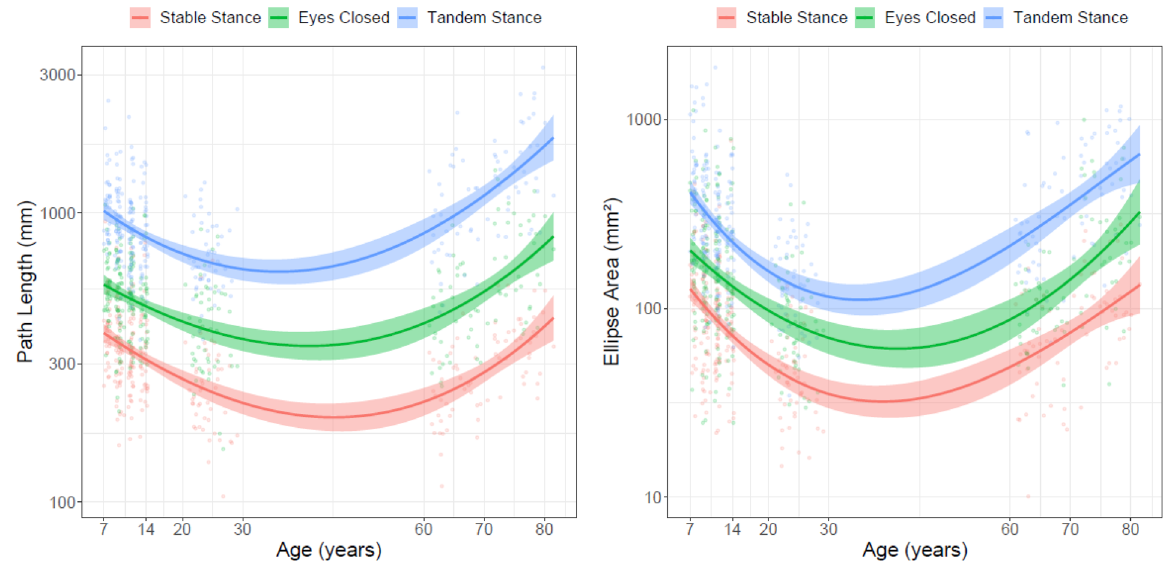
Figure 1. U-shaped pattern of postural stability across the lifespan for planar path length (left) and ellipse area (right) indicating significant differences between experimental conditions as well as reliable age-related changes within children and older adult groups (see Supplementary Table 1 and 2). Error envelope = ± 1SE.